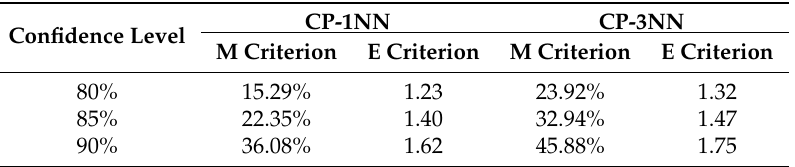
Table 5. Criterion of efficiency for online conformal